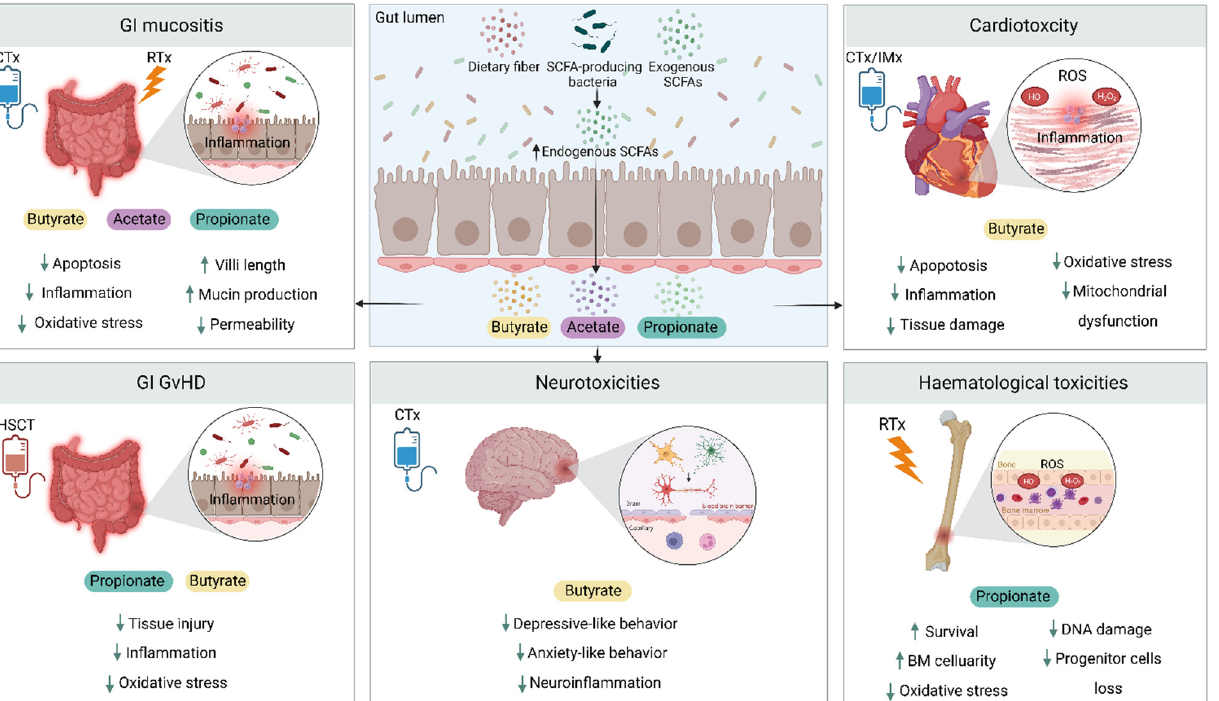
Figure 3. The role of SCFAs in cancer treatment toxicities based on current evidence. SCFAs can alleviate chemotherapy, radiotherapy, and HSCT-induced GI damage associated with mucositis and GvHD by reducing cell death, inflammatory and oxidative stress responses, and decreasing intestinal permeability by protecting villi length and enhancing mucin production. Butyrate protects against chemotherapy-related cardiac toxicities by reducing tissue injury, inflammation, oxidative stress, and mitochondrial dysfunction. Butyrate also has beneficial effects against chemotherapy- induced behavioral changes and neuroinflammation. Propionate protects against hematological toxicities by enhancing bone marrow cellularity and reducing DNA damage, oxidative stress, and progenitor cell death. SCFAs, short chain fatty acids; GI, gastrointestinal; CTx, chemotherapy; RTx, radiotherapy; IMx, immunotherapy; ROS, reactive oxygen species; GvHD, graft-versus-host disease; HSCT, hematopoietic stem cell Table 2. Impact of SCFA-based interventions on cancer treatment toxicities. Ref.